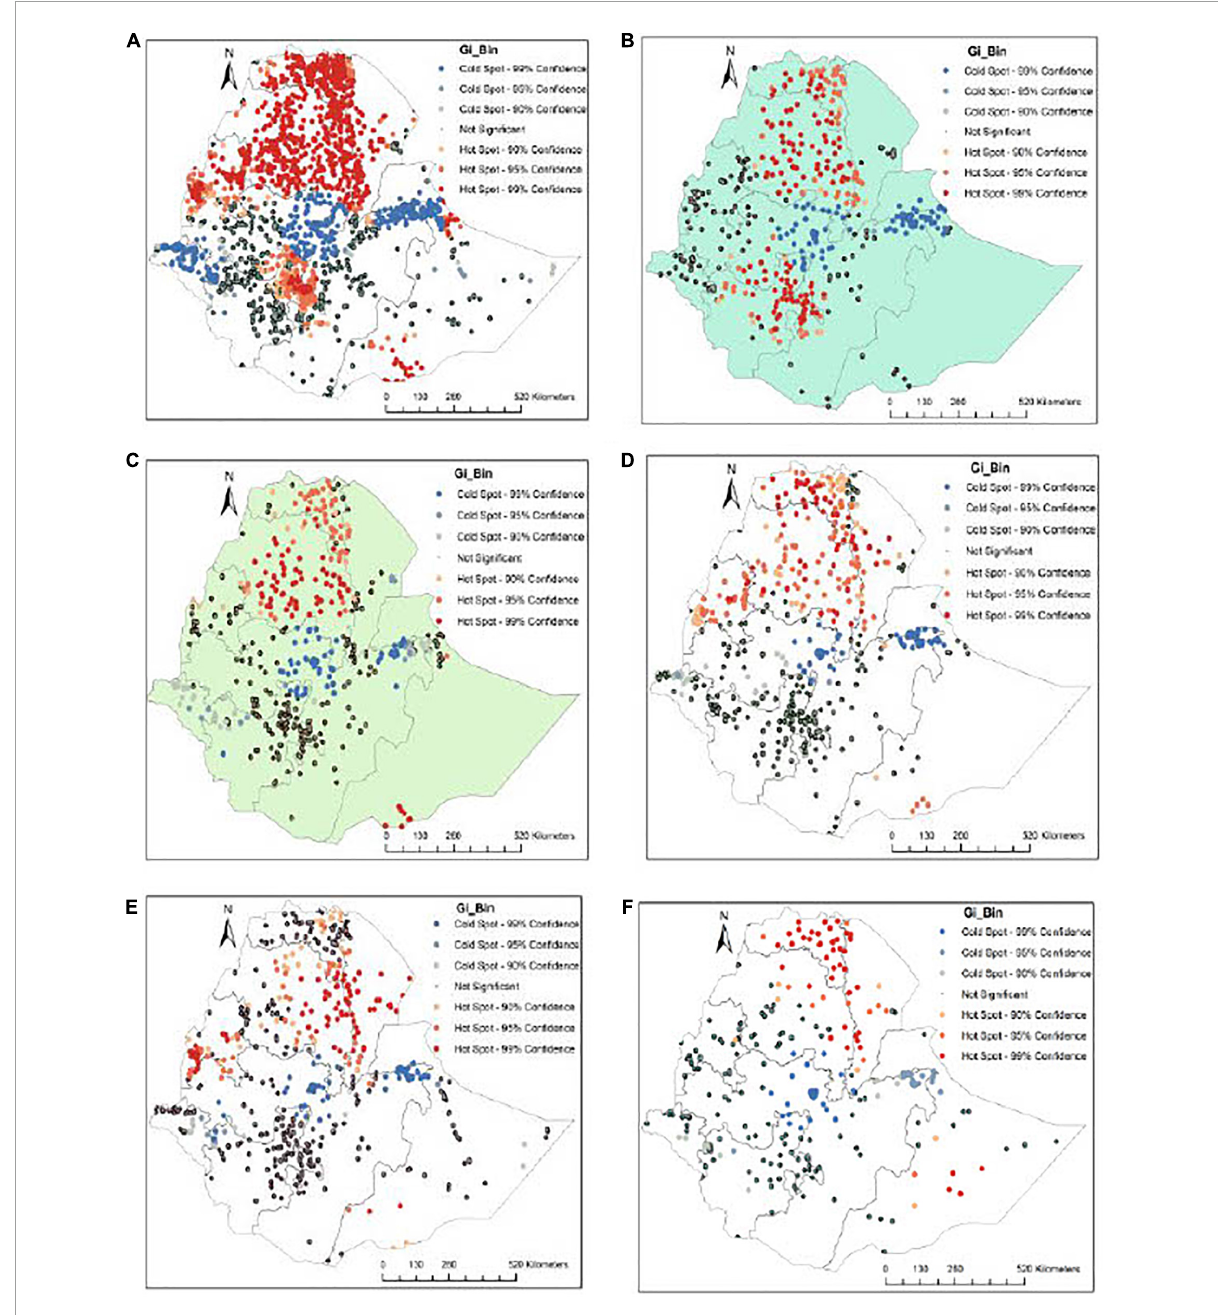
FIGURE2 Geospatial points and prevalance of underweight in Ethiopia: (A) 2000-2019, (B) 2000, (C) 2005, (D) 2011, (E) 2016, and (F) 2019.